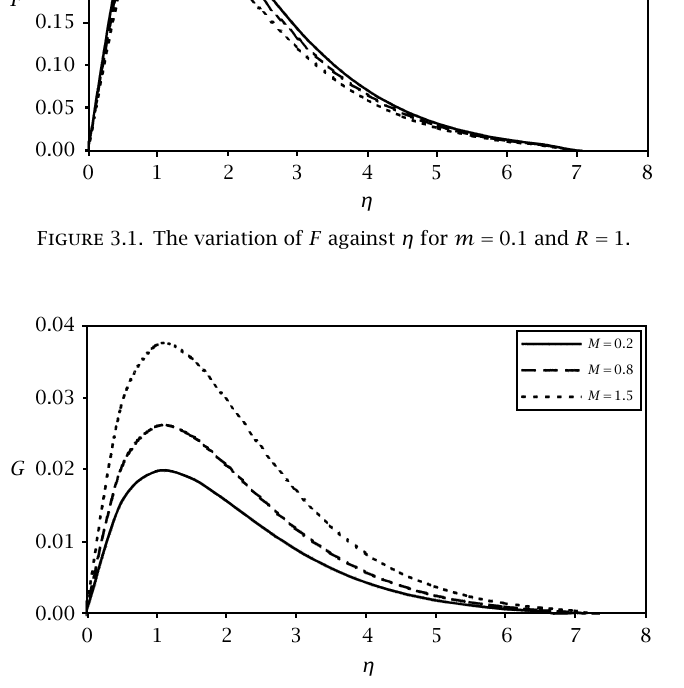
Figure 3.2 . The variation of G against η for m = 0 . 1 and R =